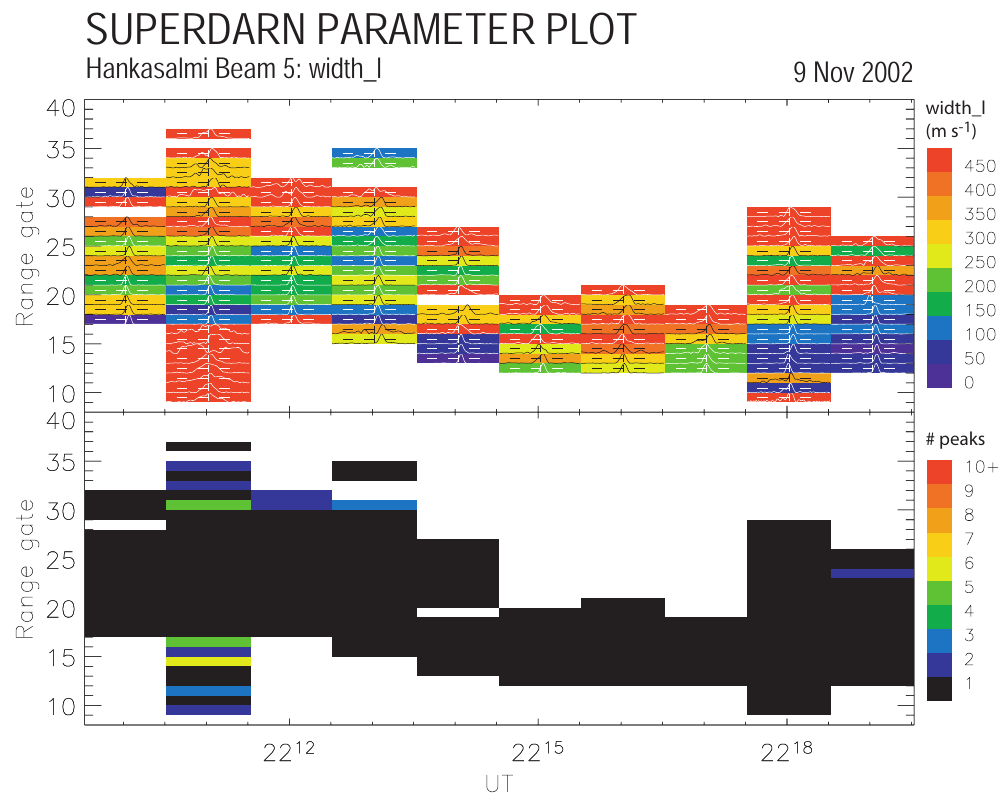
Fig. 3. Top: Spectral width (width l) data from the CUTLASS Finland radar in the same format as Fig. 1 but for the interval 22:09:30– 22:19:30UT. Overlaid on each cell are velocity power spectra derived from the FFT of the radar ACF directly. Vertical lines indicate zero Doppler velocity. Bottom: The number of spectral peaks identified, within 3dB of the peak spectral